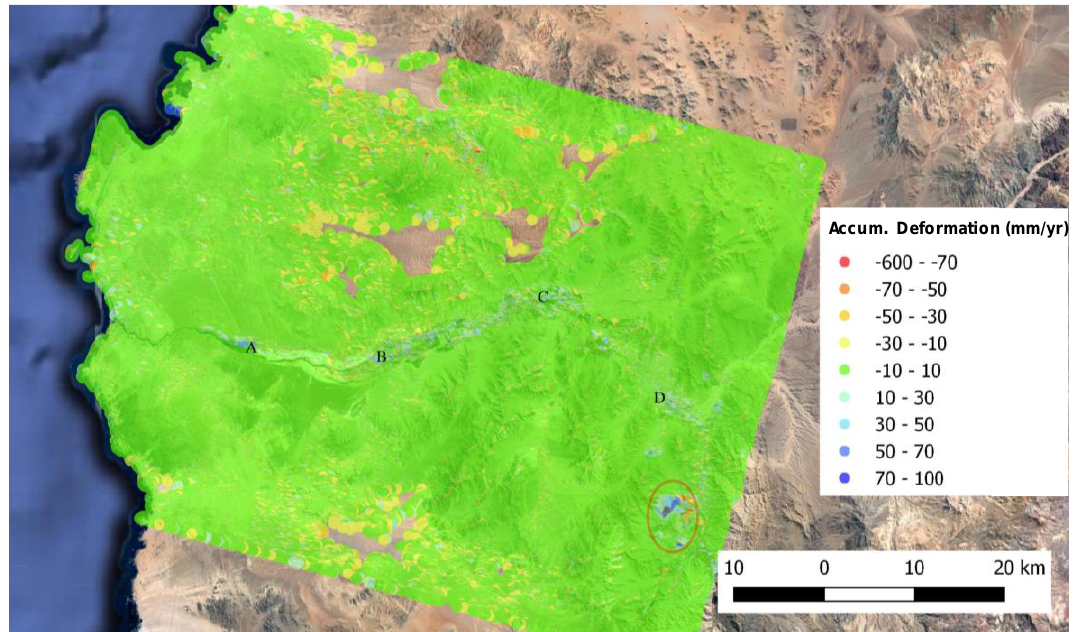
Figure 4. Displacement map of the Copiapó Basin superimposed to an optical image of Google